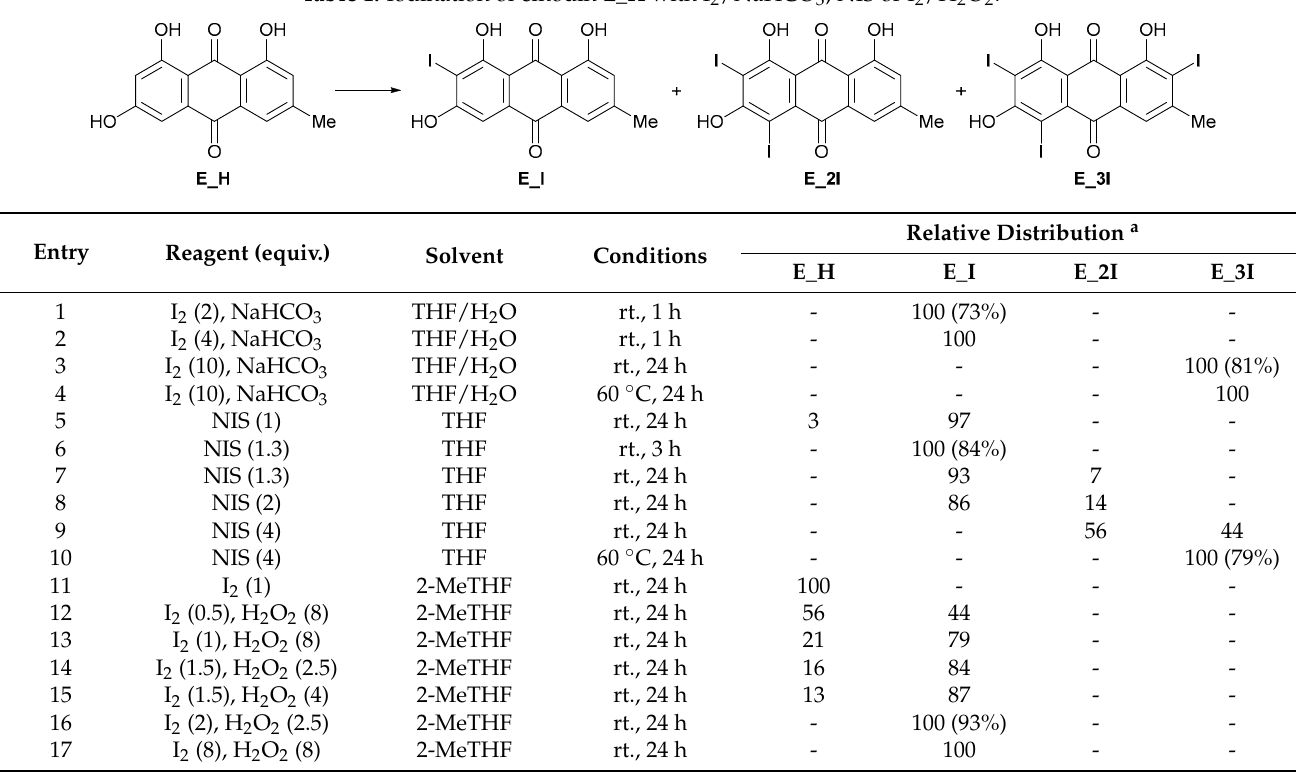
Table 1. Iodination of emodin E_H with I 2 /NaHCO 3 , NIS or I 2 /H 2 O 2 .